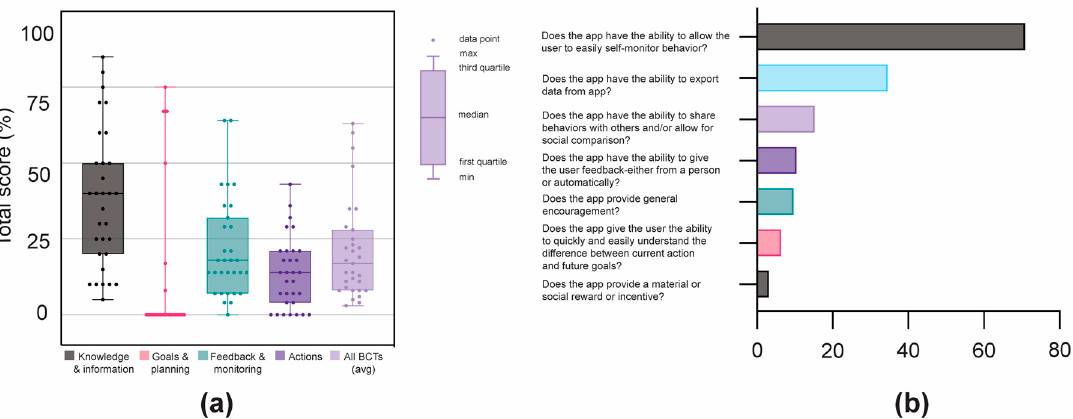
Figure 4. Behaviour change techniques (BCTs) and feedback and monitoring scores. ( a ) Pregnancy app performance by BCT category. ( b ) Breakdown (%) of overall app scores in the ‘feedback and